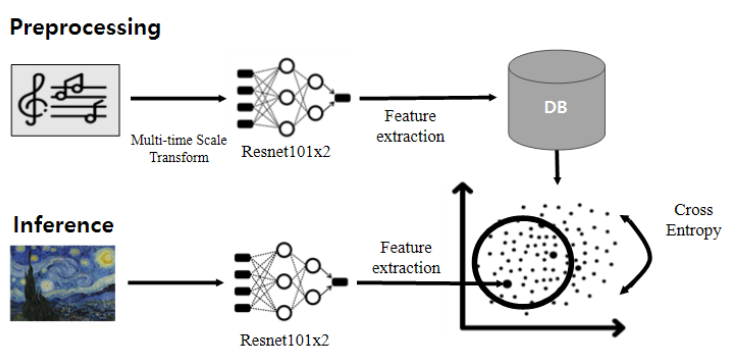
Figure 1. Our service application architecture, consisting of a preprocessing phase before the service and an inference phase at runtime. This figure shows a music–artwork matching method for soundscape